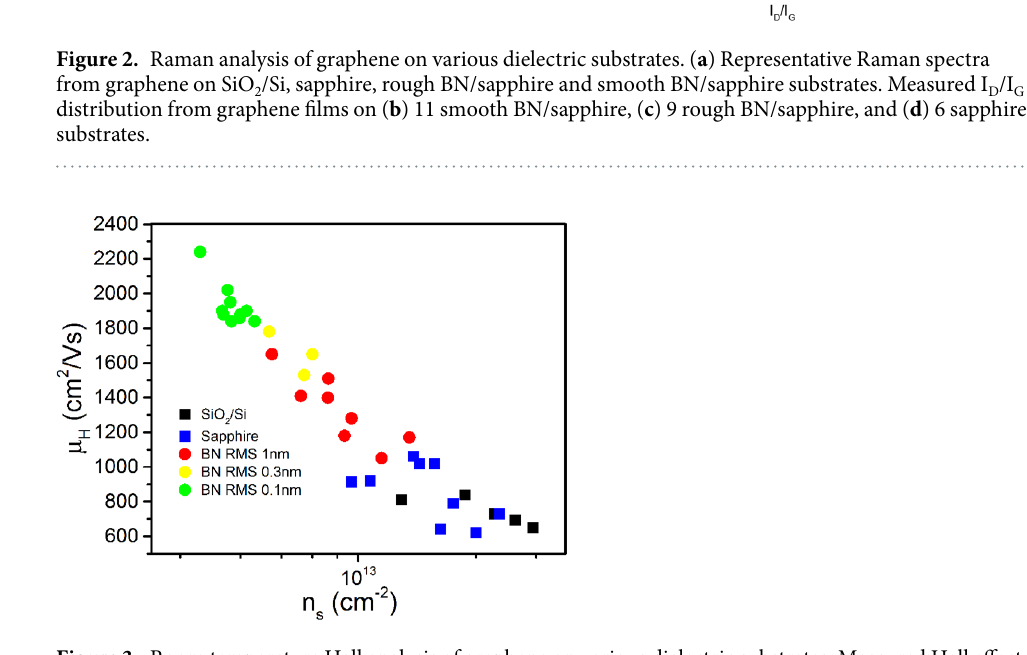
reproducibility of the BN MOCVD growth and graphene transfer processes. The D/G intensity ratio (I D /I G ) taken from multiple spots on each sample was used for comparison, Fig. 2b–d. On sapphire the mean I D /I G is 0.09 with